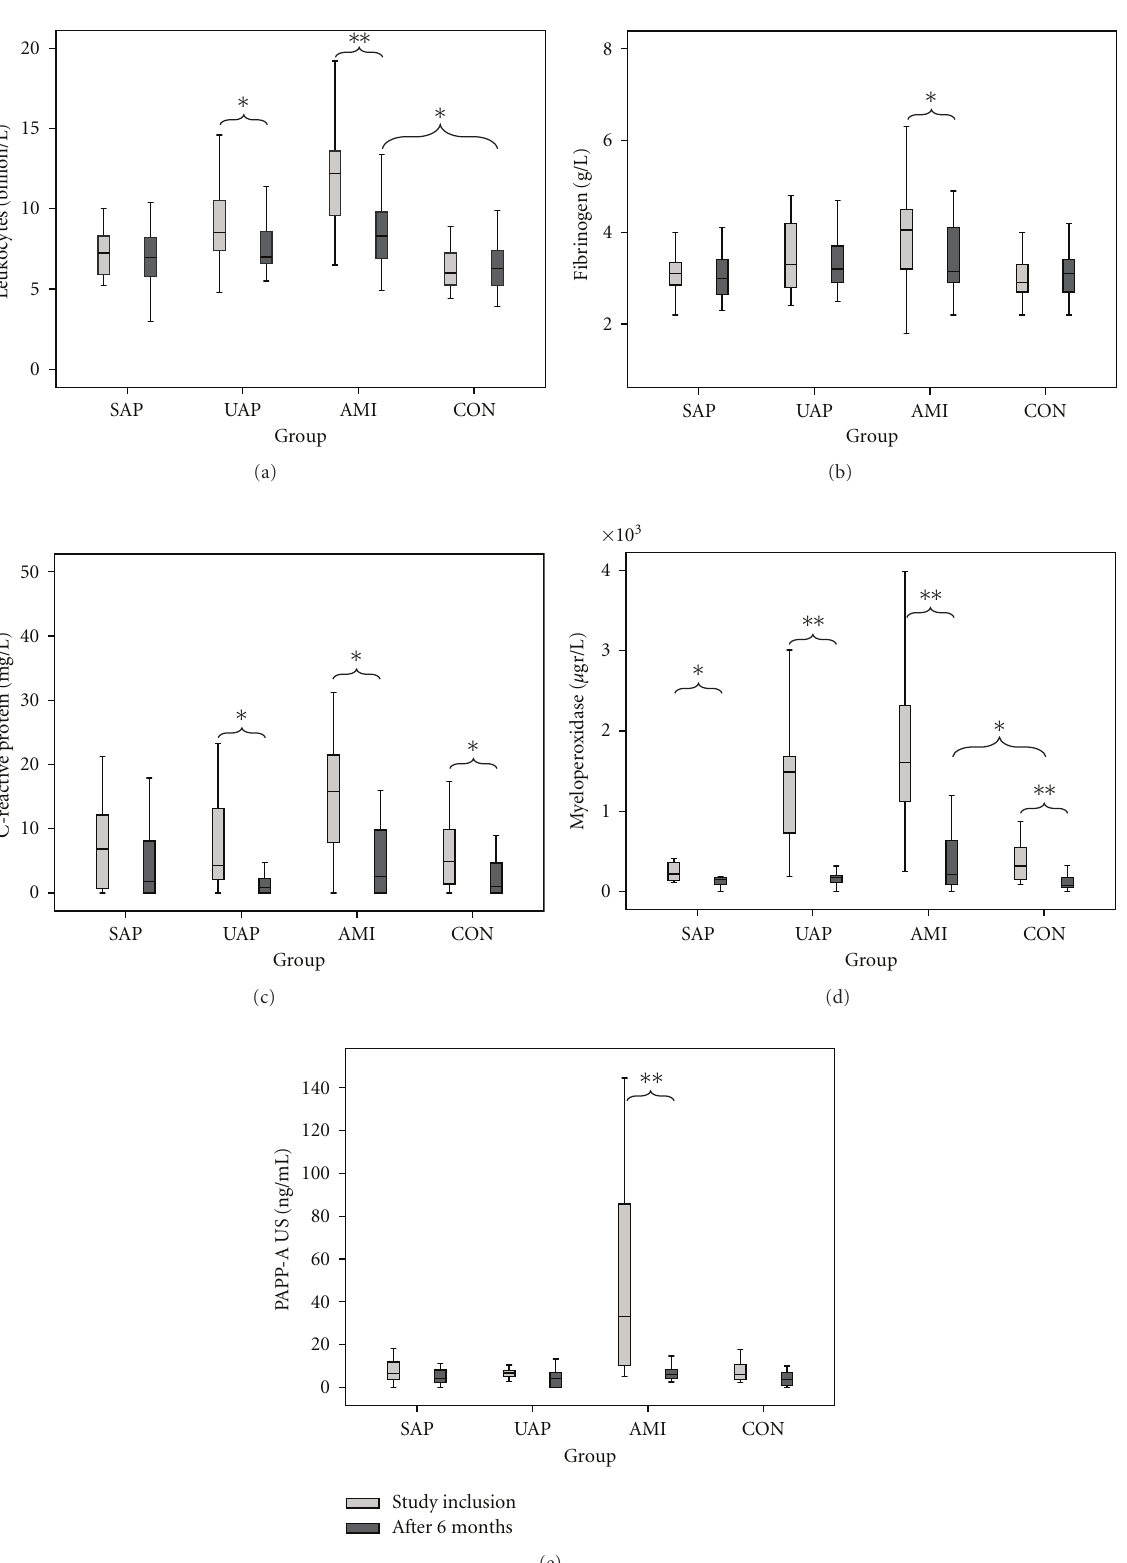
Figure 2: Boxplots of biomarker levels of leukocyte counts (a), fibrinogen (b), C-reactive protein (c), myeloperoxidase (d), and ultrasensitive pregnancy-associated plasma protein A (e) at study inclusion and after 6-month followup. Statistical di ff erences at 6-month followup were expressed as P < . 05 ( ∗ ) or P ≤ . 001 ( ∗∗